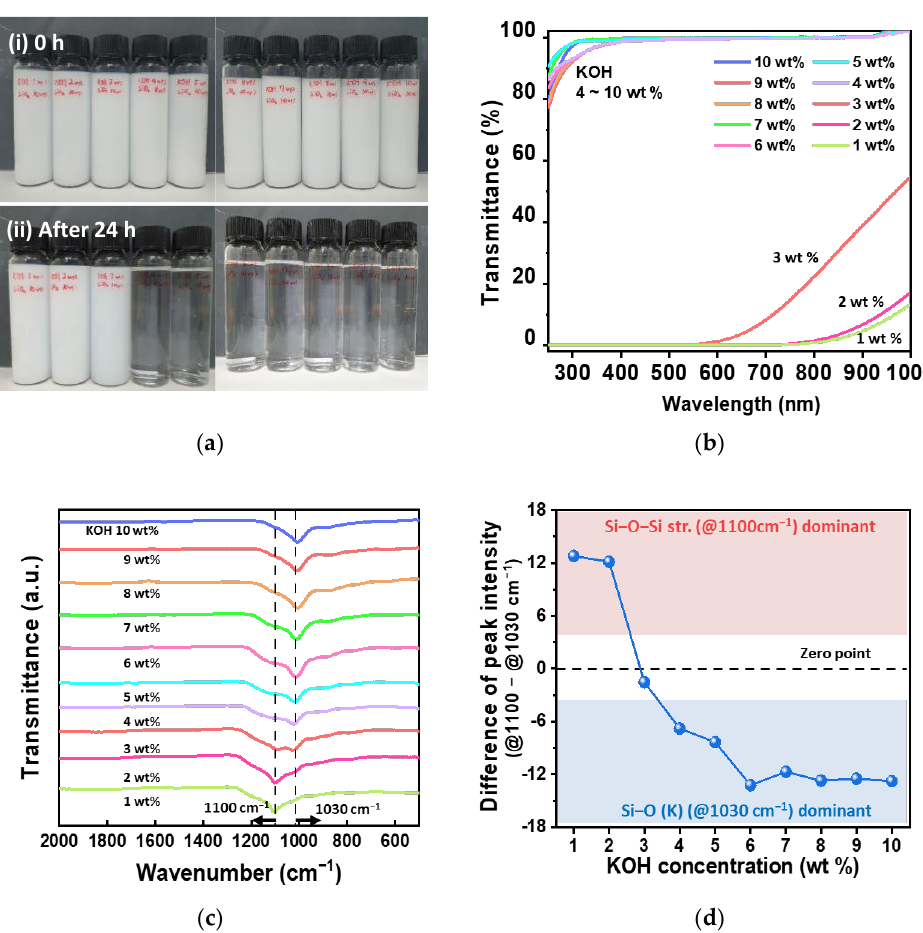
Figure 2. Dependency of dissociation of fumed silica on KOH weight ratio. ( a ) Photographs of potassium silicate solutions (i) before and (ii) after 24 h. The KOH concentrations of the solutions are 1 to 10 wt% in order from the left side of the photographs. ( b ) Transmittance spectra at wavelengths of 300 − 1000 nm measured by UV – visible spectroscopy. ( c ) Transmittance spectra at wavenumbers of 500 − 2000 cm − 1 measured by FT − IR. ( d ) Difference of peak intensity at vibration of Si − O − Si peak (1100 cm −1 ) and Si − O (K) (1030 cm −1 ) peak.